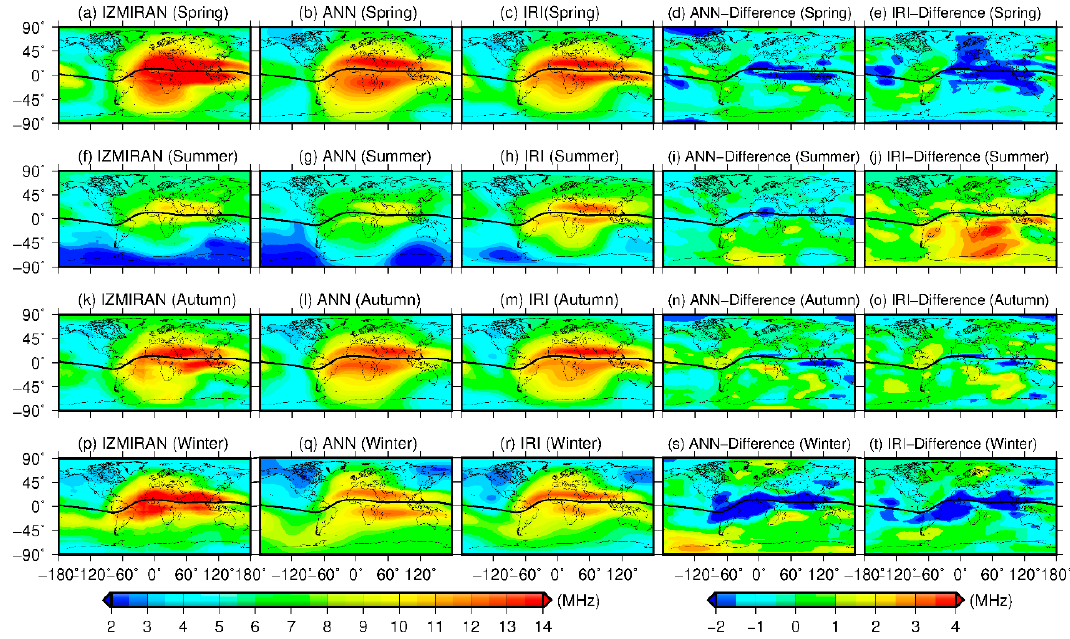
Figure 9. Comparative analysis of global foF2 maps of IZMIRAN, ANN and IRI at noon in four seasons. The black line represents the geomagnetic equator.